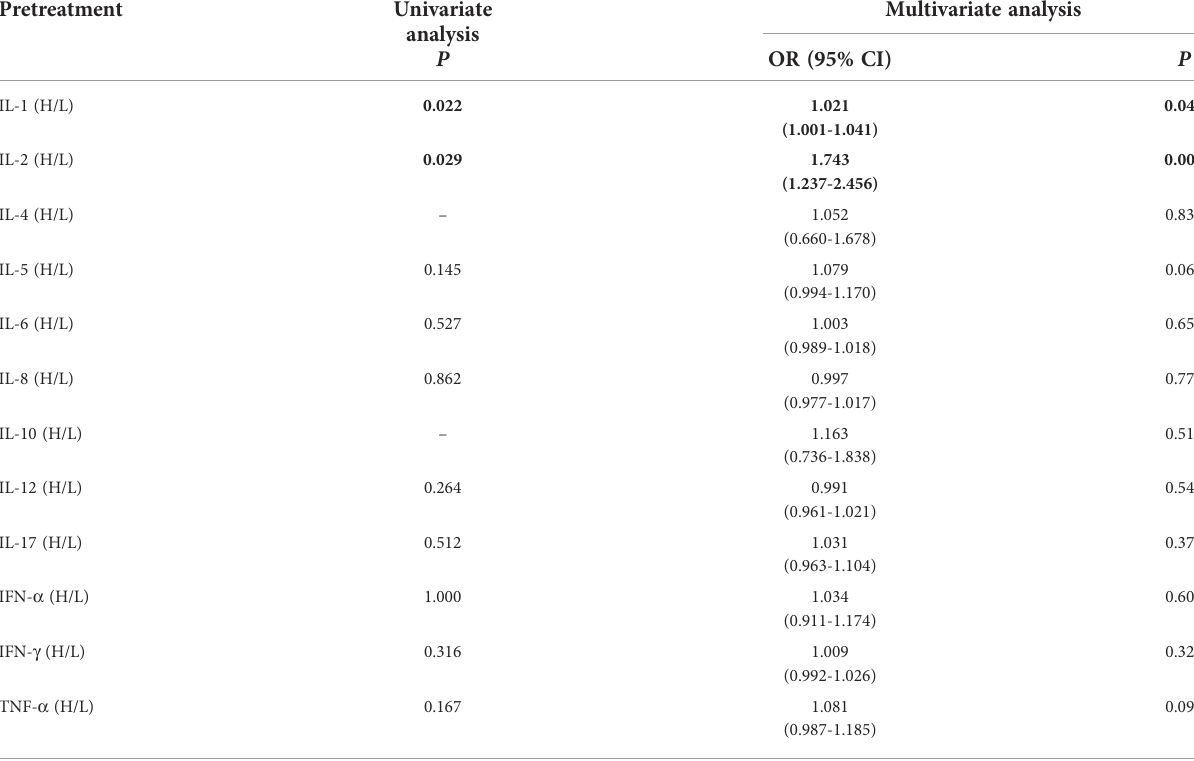
TABLE 2 Univariate and multivariate analysis results of baseline cytokine levels between AE and NAE.